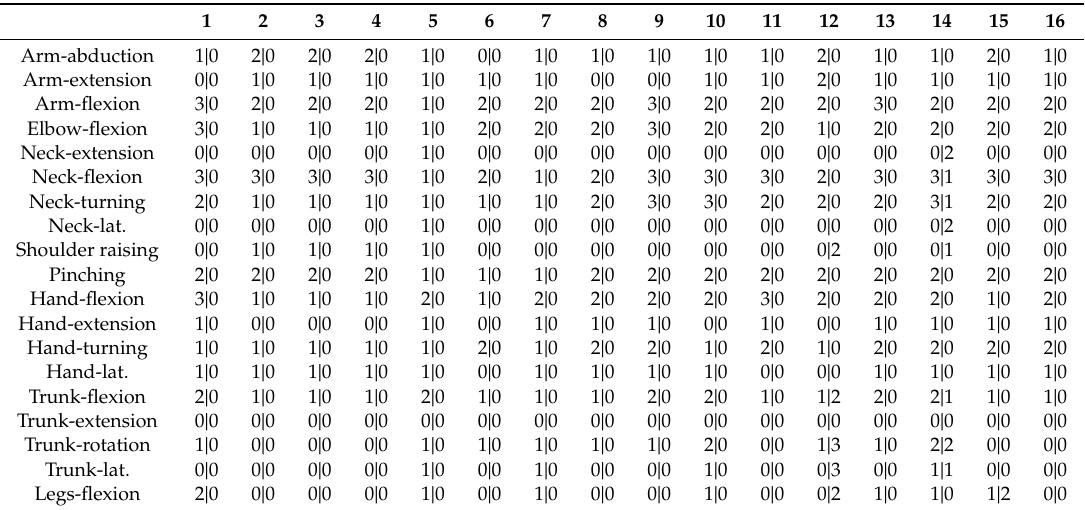
Table 3. Scores of the items of the “Movements” group for the 16 workstation and workers. The first number in each cell is the workstation score, the second one is the worker score.